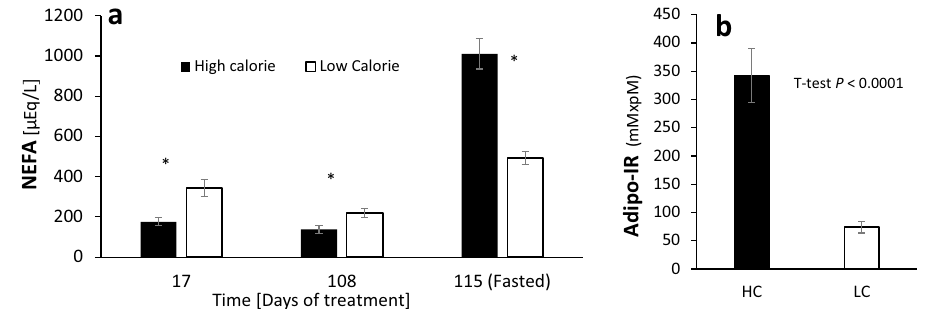
Figure 2. Non-esterified fatty acid (NEFA) and adipose insulin resistance in response to the high- and low- calorie treatments. ( a ) Plasma NEFA concentrations. Repeated measures ANOVA shows an effect of treatment ( P < 0.0001) and time ( P < 0.009). SEM = 16.9. Fasting levels were not included in the model and analysed independently by a student’s t-test and the significance level was Bonferroni-Holm corrected. * P < 0.05. ( b ) the log-transformed values.